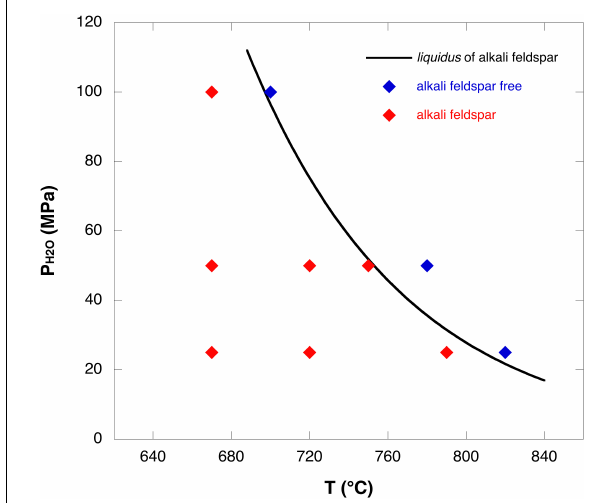
FIGURE 1 | Phase diagram for alkali feldspar. The solid line represents the liquidus of alkali feldspar under water-saturated conditions at NNO+0.8. Blue diamonds, alkali feldspar-free charges; red diamonds, alkali feldspar-bearing charges.